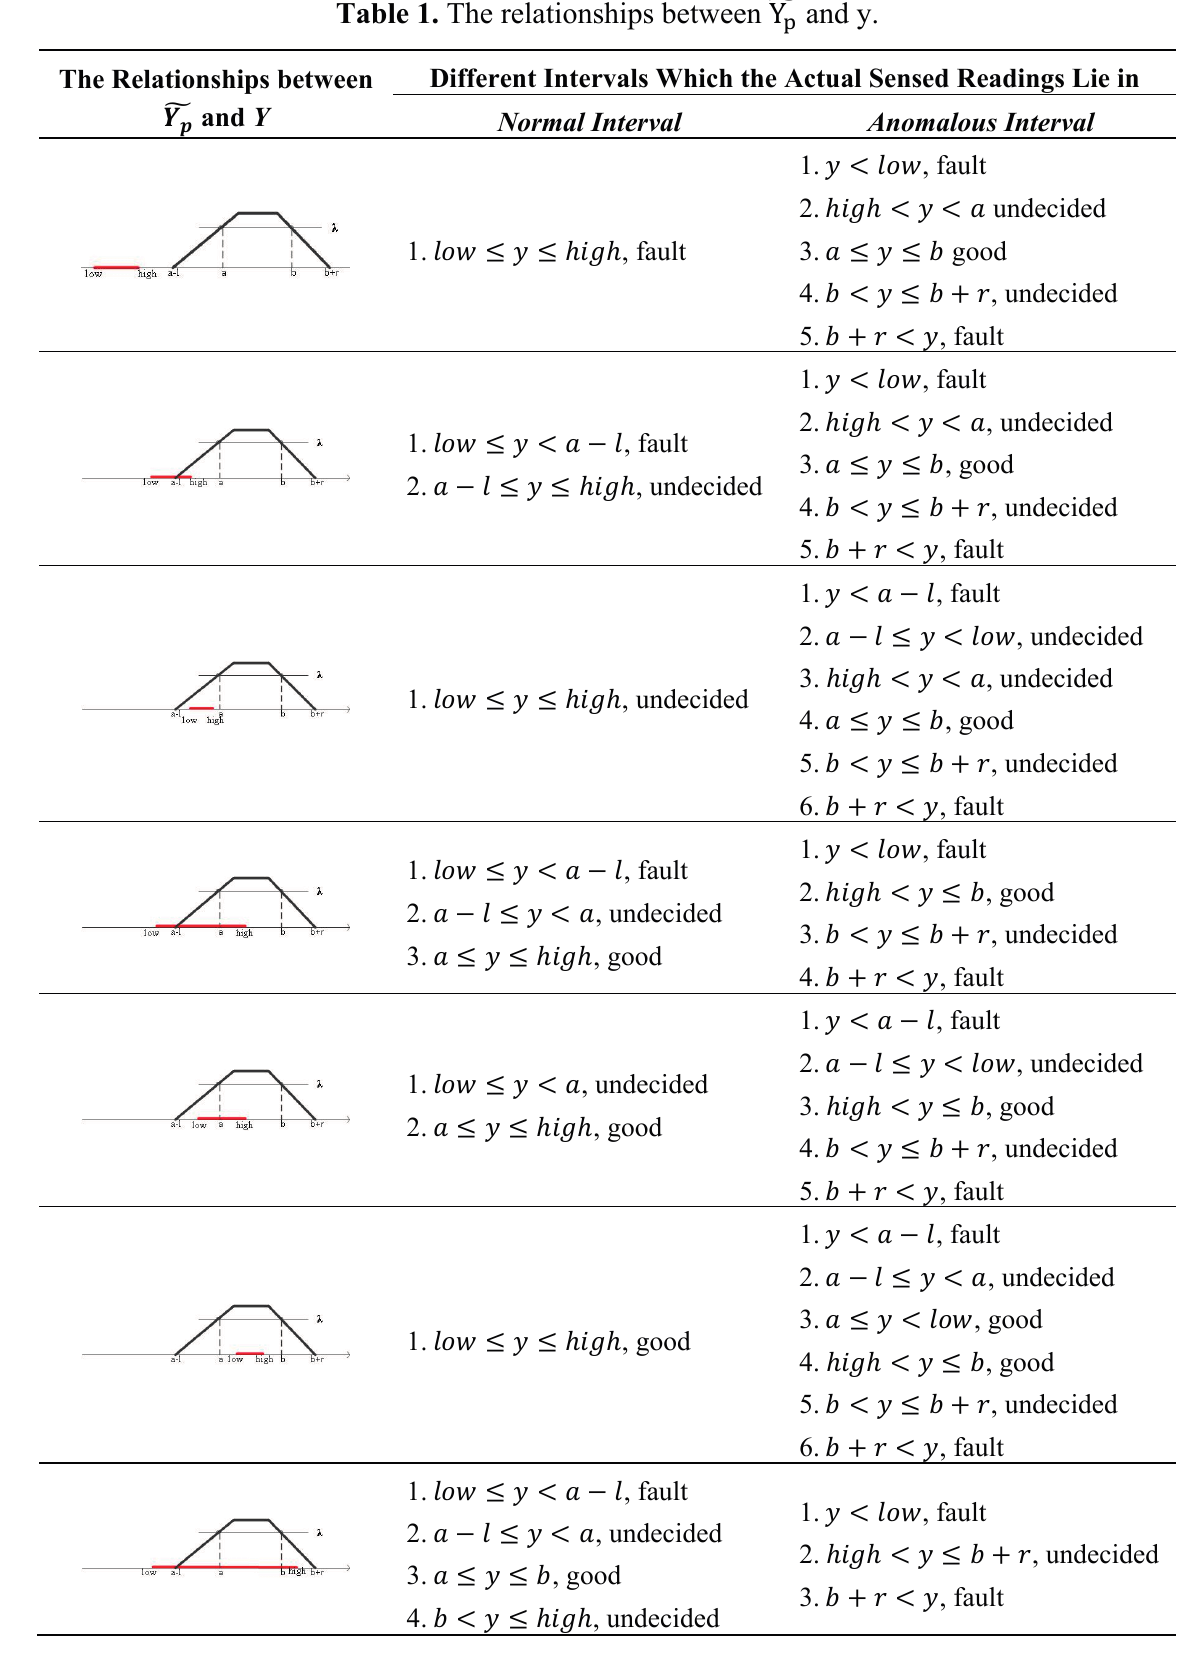
Table 1. The relationships between Y